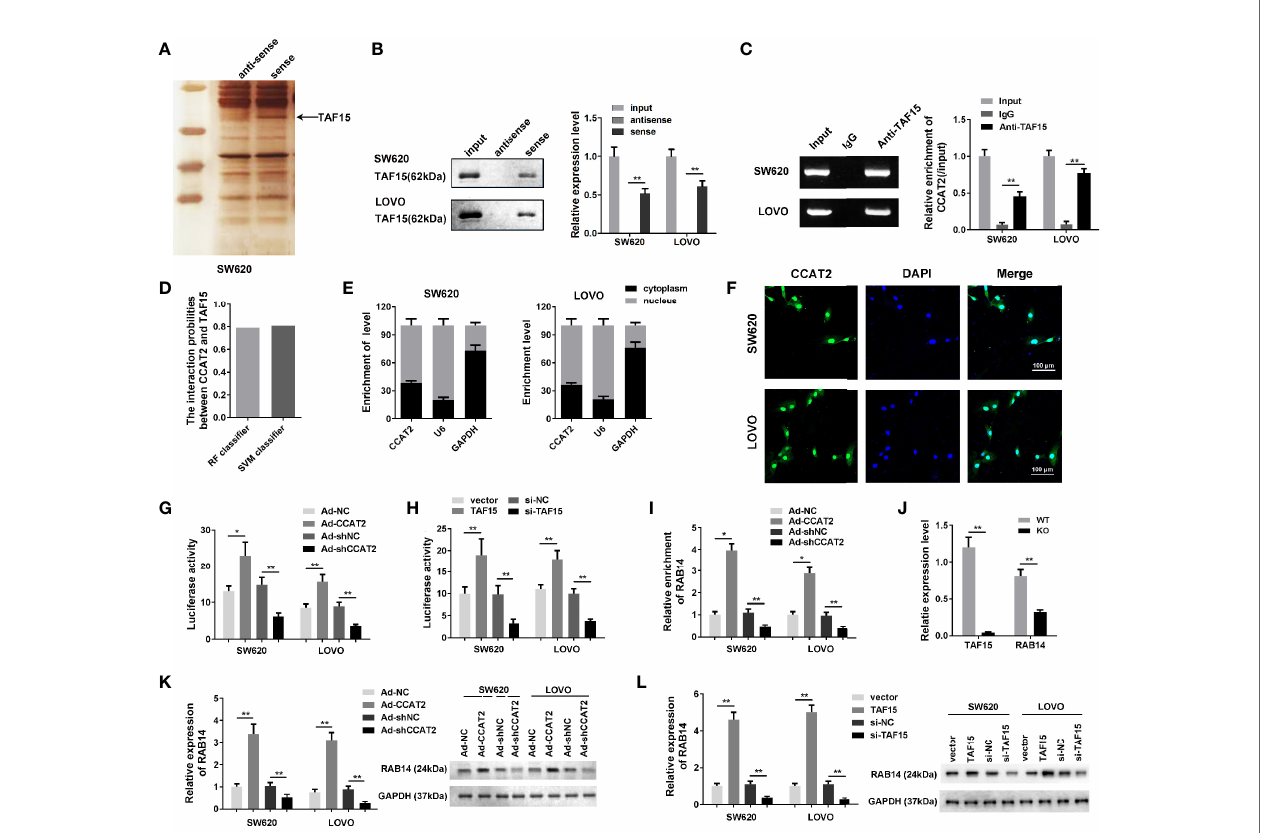
FIGURE 4 | CCAT2 regulated the expression level of RAB14 via interaction with TAF15. (A, B) The RNA pull down assay was carried out by biotinylated CCAT2 probe and silver staining to reveal the factors underlying the mechanism of CCAT2 in CRC cells. Mass spectrometry analysis highlighted TAF15 as a potential factor interacting with CCAT2 (A) . The interaction of CCAT2 and TAF15 was further veri fi ed the by Western blot (B) and RIP assay (C) . (D) Bioinformatic prediction showing the potential interaction of CCAT2 and TAF15. (E) The cellular localization of CCAT2 as determined though nuclear and cytoplasmic separation test and qPCR. (F) FISH was performed to determine the localization of CCAT2 in the cells. (G, H) The transcriptional activity of RAB14 was measured by dual luciferase reporter assay in SW620 and LOVO cells after being infected or transfected with Ad-CCAT2, Ad-shCCAT2, TAF15, si-TAF15 and their corresponding controls. (I) ChIP analysis indicated that CCAT2 promoted the binding between ATF15 and the promtor of RAB14 while CCAT2 knockdown inhibited that. (J) Measurement of TAF15 and RAB14 levels by qPCR. Total RNA was extracted from SW620 cells that were transfected with CRISPR/Cas9 to knockdown TAF15. (K, L) Expression of RAB14 in cells infected with Ad-CCAT2, Ad-shCCAT2, TAF15, or si-TAF15 as measured by Western blot. Protein levels are shown as bar graphs. The data are represented as mean ± SD. Three independent biological repeats were used for each analysis. *P < 0.05, **P <